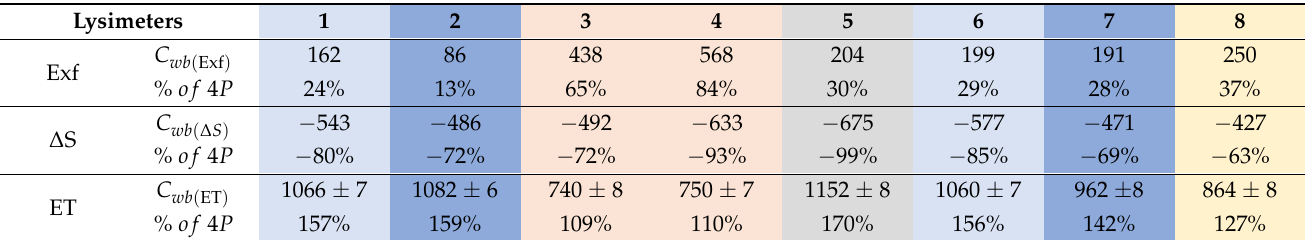
Table 5. Cumulative water balance components (C wb ) in mm over the 305 common validated days, for the 8 lysimeters. Cumulated rain (4P) is 679 ± 6